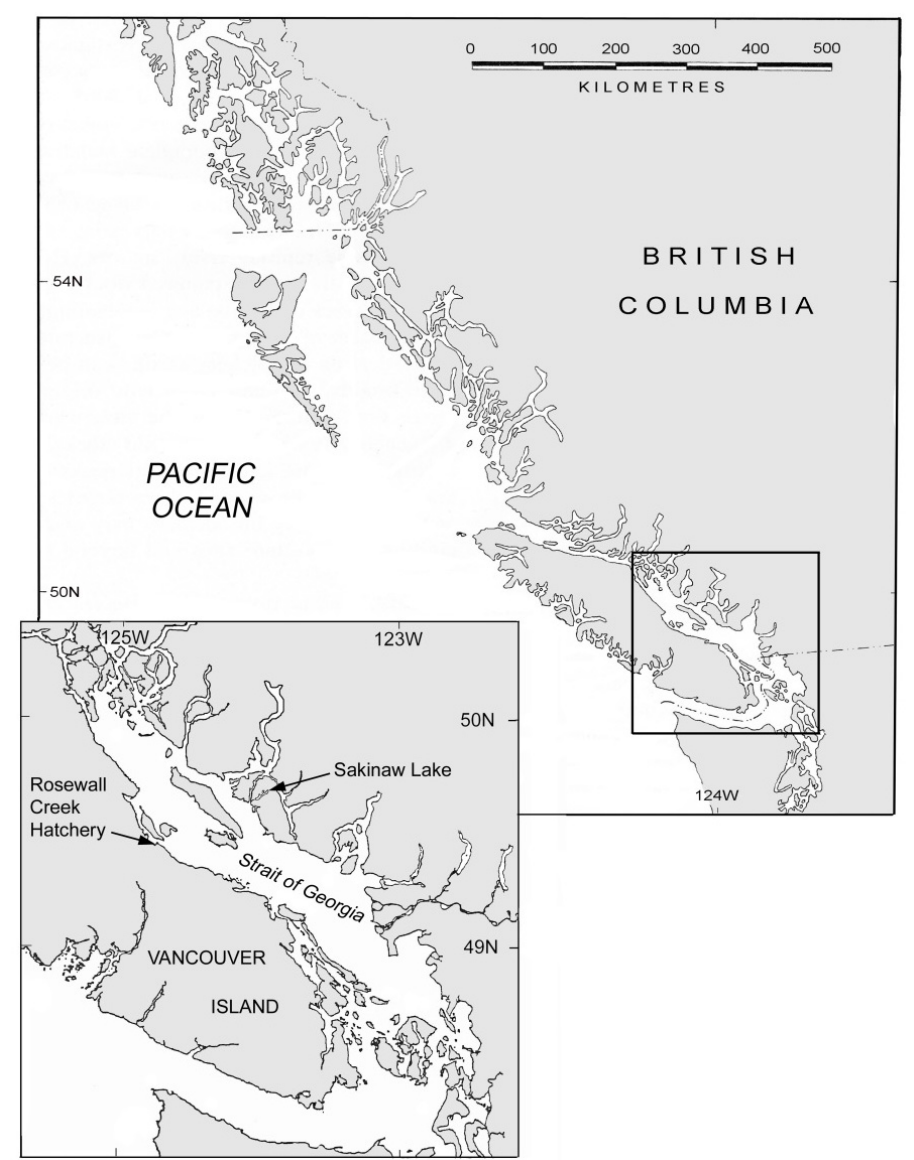
Figure 1. Location of Sakinaw Lake in southern British Columbia, Canada. Rosewall hatchery on Vancouver Island, where captive breeding of Sakinaw sockeye salmon was conducted, is also shown in